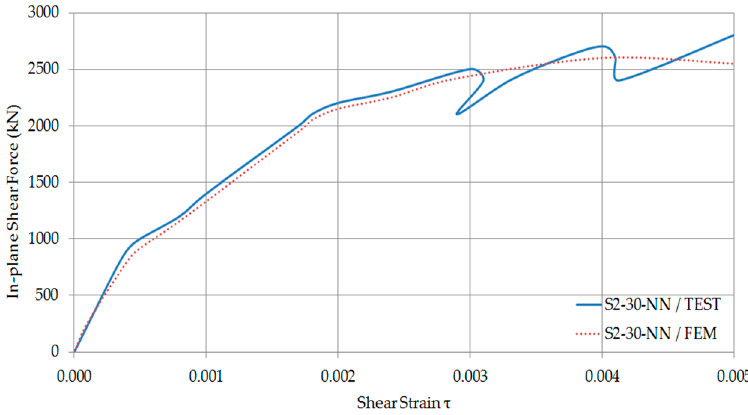
Figure 17. In-plane shear force—Shear strain Curves of S2-30-NN.